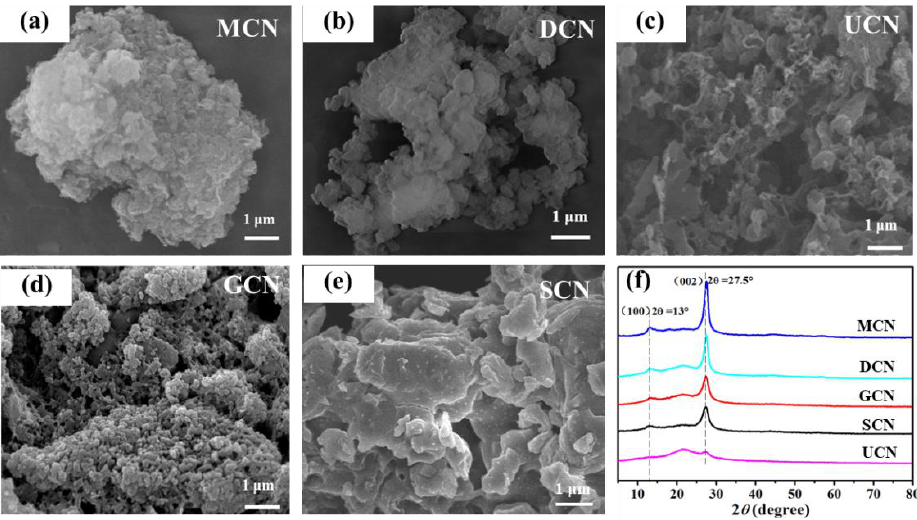
Figure 1. FESEM images of ( a ) MCN, ( b ) DCN, ( c ) UCN, ( d ) GCN and ( e ) SCN. ( f ) XRD patterns of all as-prepared